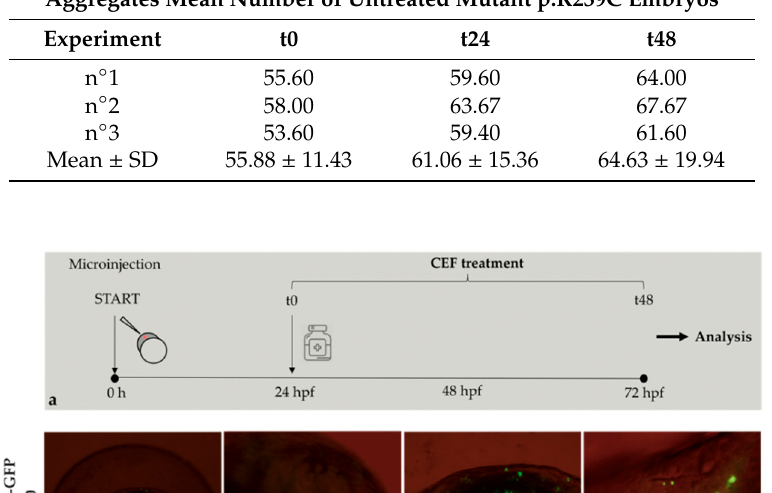
Table 2. Details of the aggregates number count are reported for untreated mutant p.R239C embryos.. Means and standard deviations are described at the bottom the table.